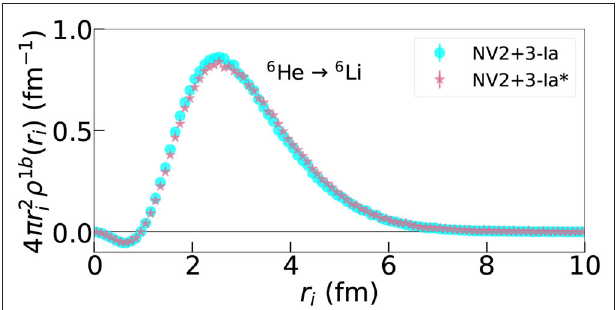
FIGURE 2 | One-body density as defined in Equation (12) for the 6 He → 6 Li GT RME obtained using the NV2+3-Ia/Ia* models.